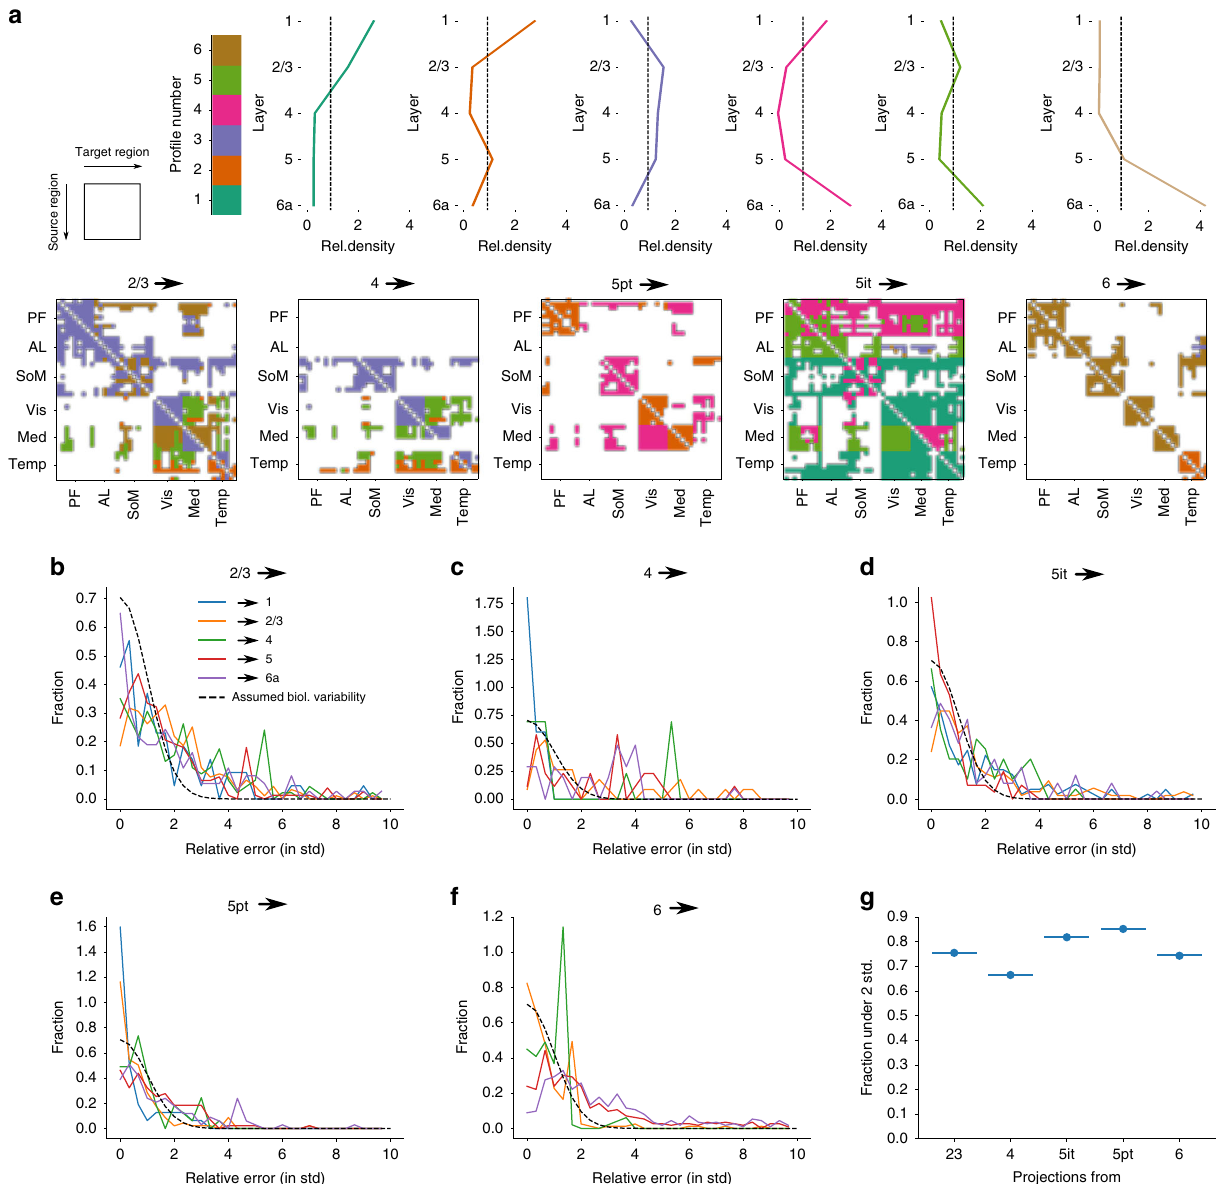
Fig. 2 Predicted layer pro fi les. a Predictions for all projection classes. Exact order of brain regions and assignment to modules by Harris et al. 3 are also listed in Supplementary Table 1. b – f Relative error of the predicted synapse densities in all layers. That is, the difference between prediction and the mean of the raw biological data, divided by the standard deviation of the biological data. b For projections from L2/3. c From L4. d From L5IT. e From L5PT. f From L6. Dashed black lines indicate the biological variability of density under the assumption that it is Gaussian distributed. We used only projections where more than fi ve raw data points to establish the biological variability were available. g Fraction of projections where with the relative error under two standard deviations for each source